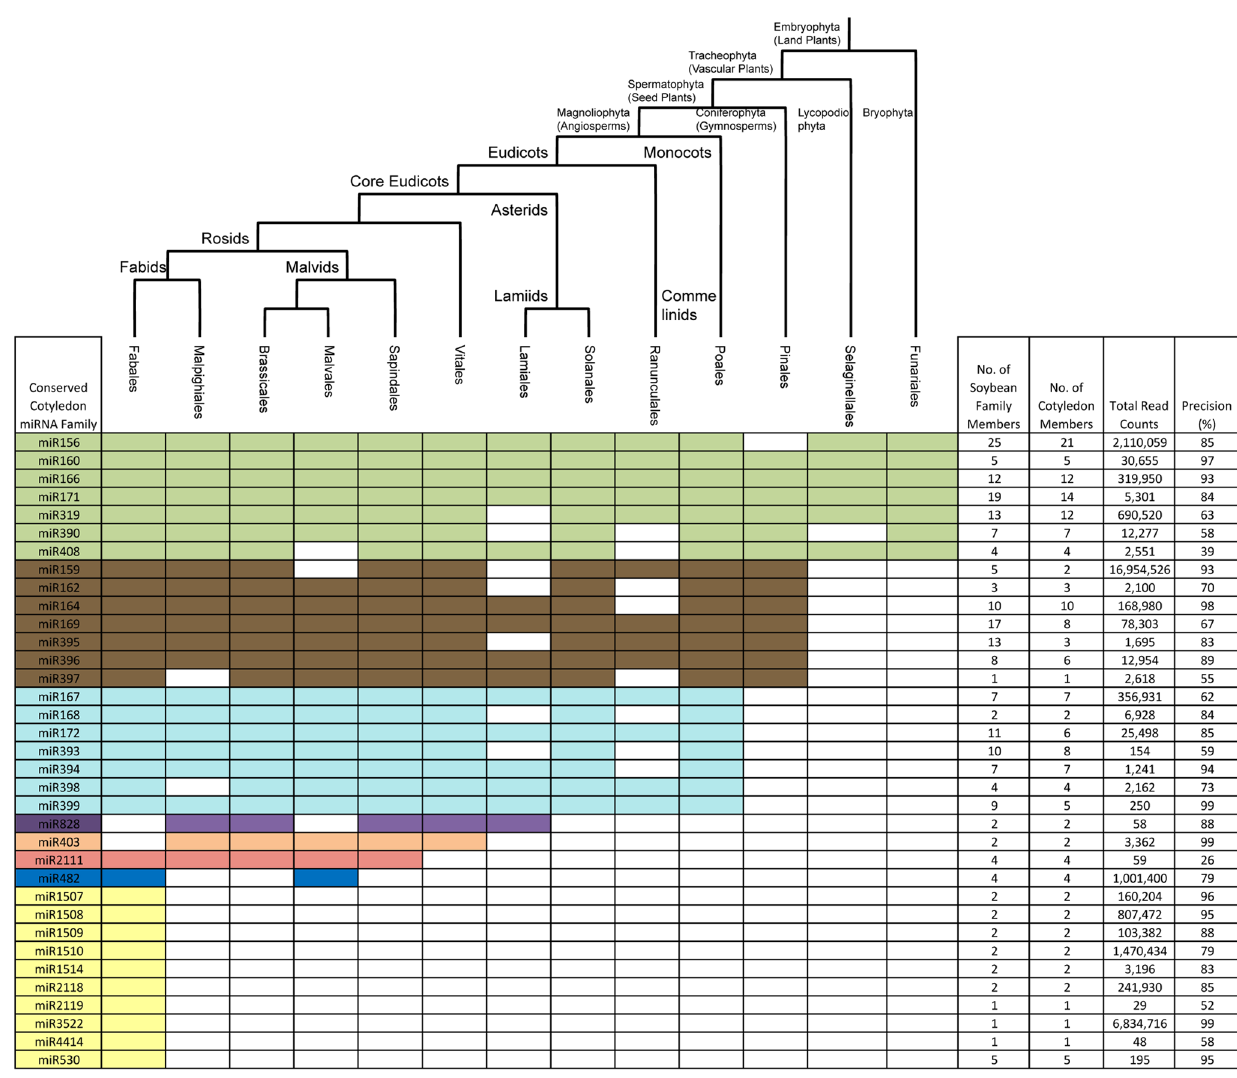
Figure 2. Conserved Soybean Cotyledon miRNAs in Divergent Orders of Land Plants. The conservation of soybean cotyledon miRNA families across plant species belonging to 12 orders is presented. The presence of a miRNA family that is conserved with a soybean cotyledon miRNA in at least one plant species in a given order is shown by differently colored cells. Green cells indicate conservation in land plants, brown cells in seed plants, light blue cells in angiosperms, purple cells in core eudicots, tan cells in vitales, red cells in sapindales, blue cells in rosids and yellow cells in fabales. The evolutionary relationship among the 13 orders is illustrated by the phylogenetic tree placed on top of the miRNA table. The number of family members in the soybean genome and the expressed family members in cotyledons, the count of miRNA reads in cotyledons, and the processing precision are shown for each conserved miRNA family.